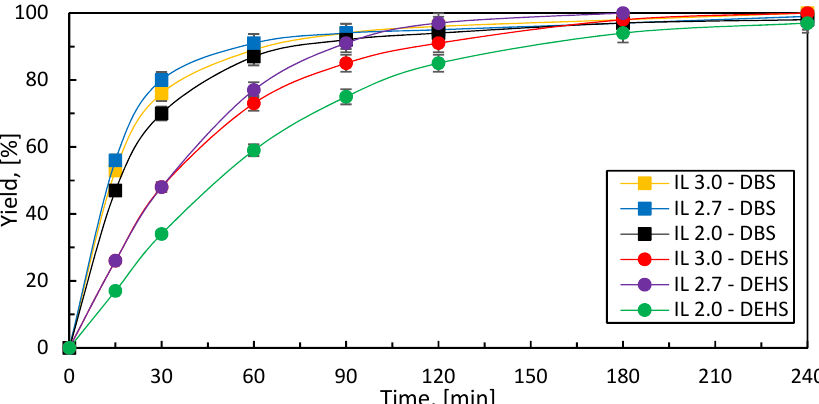
Figure 1. The influence of the IL composition on the esterification of succinic acid with butan-1-ol and 2-etylhexan-1-ol. Reaction conditions: alcohol 4 mol; succinic acid 1 mol; IL 2.7 (15 mol%/mol succinic acid (0.0025 mol)); 70 °C; 17 Hz.